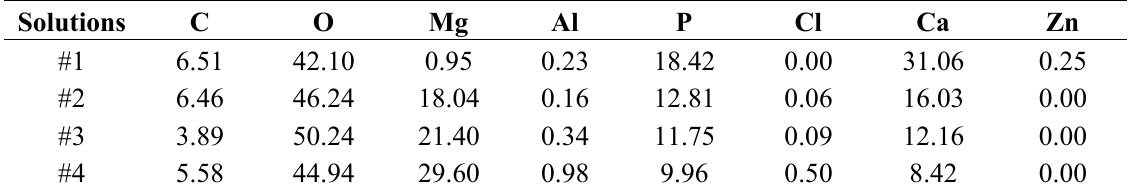
Table 1. Chemical composition of corrosion products formed on the surface